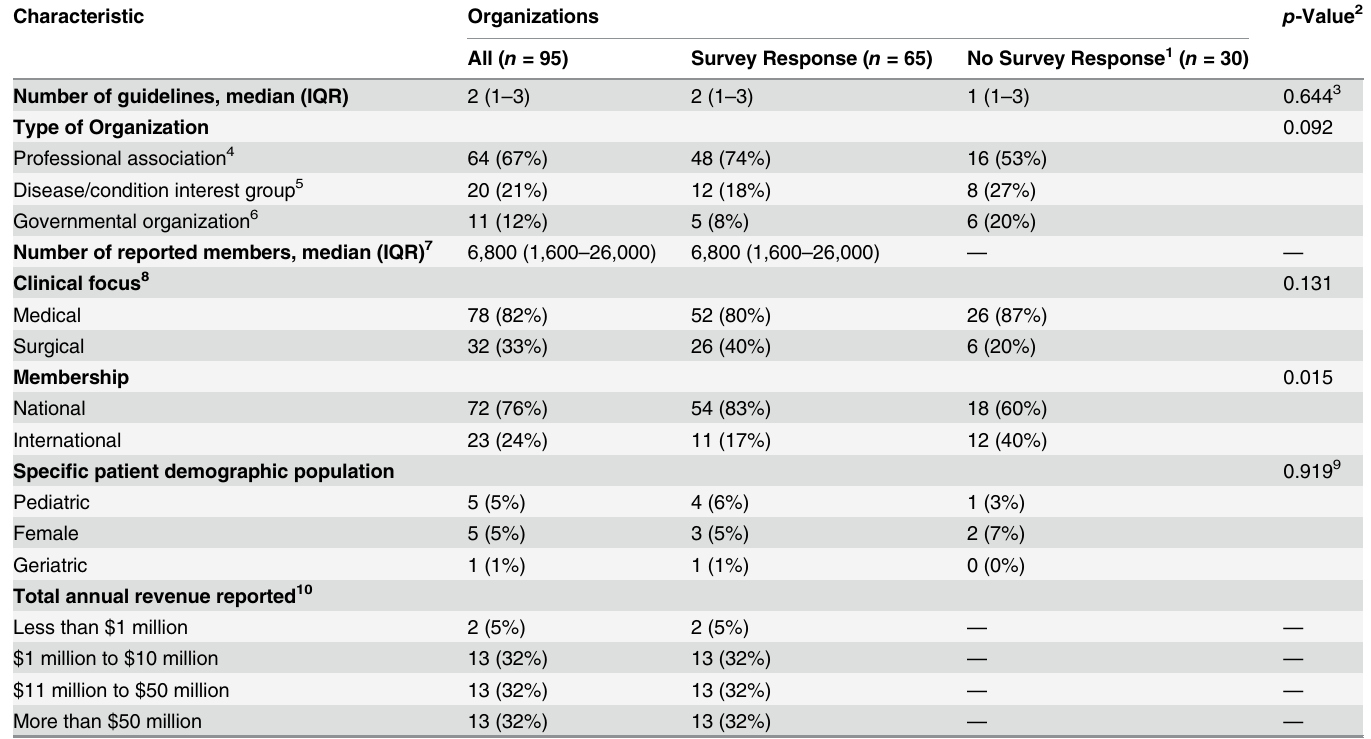
Table 1. Characteristics of the organizations that produced the clinical practice